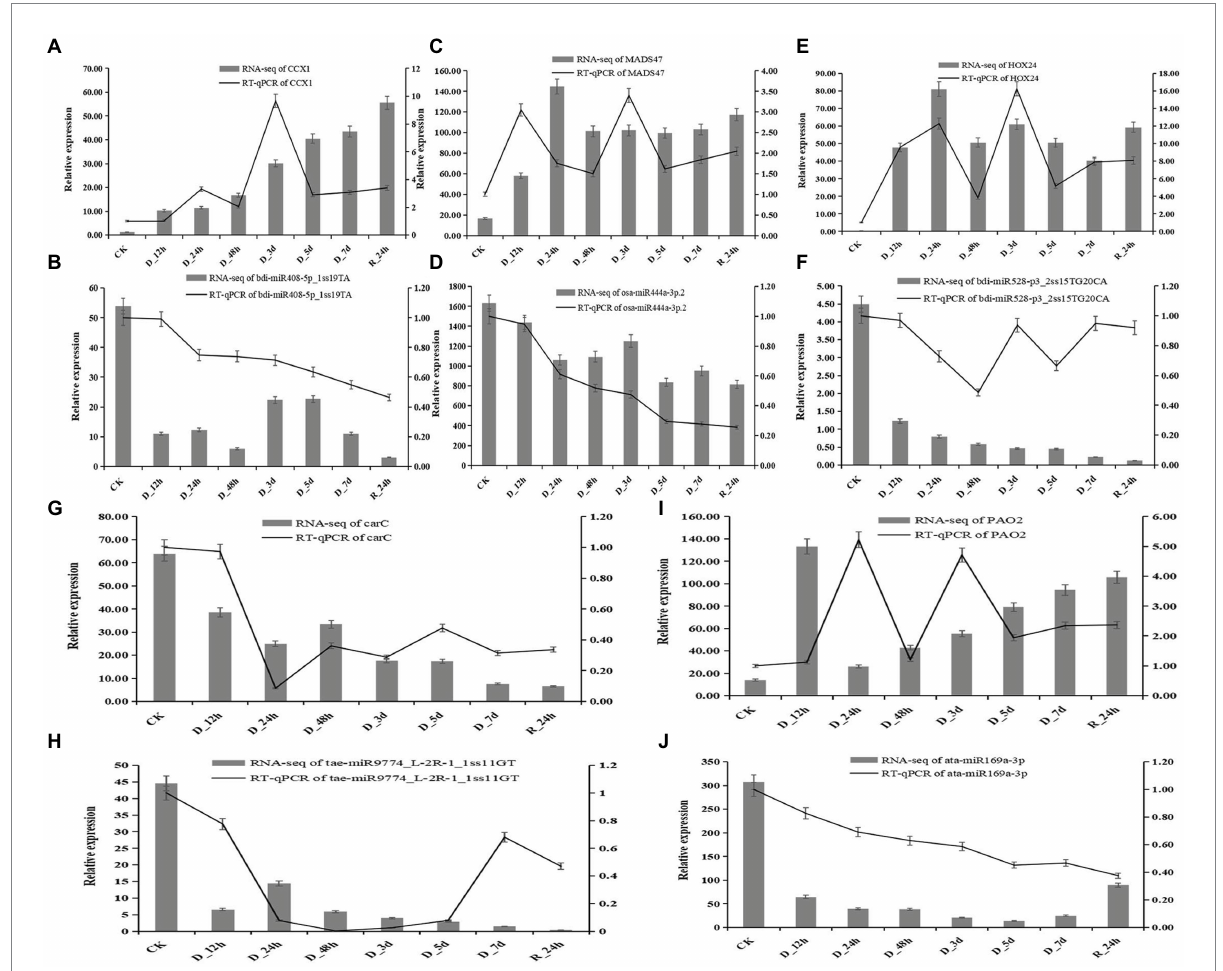
FIGURE 9 Correlation of the expression between miRNAs and the hub genes at eight durations of different drought treatments (25% PEG solution PEG6000). bdi-miR408-5p_1ss19TA target CCX1 (A,B) ; osa-miR444a-3p.2 target MADS47 (C,D) ; bdi-miR528-p3_2ss15TG20CA target HOX24 (E,F)